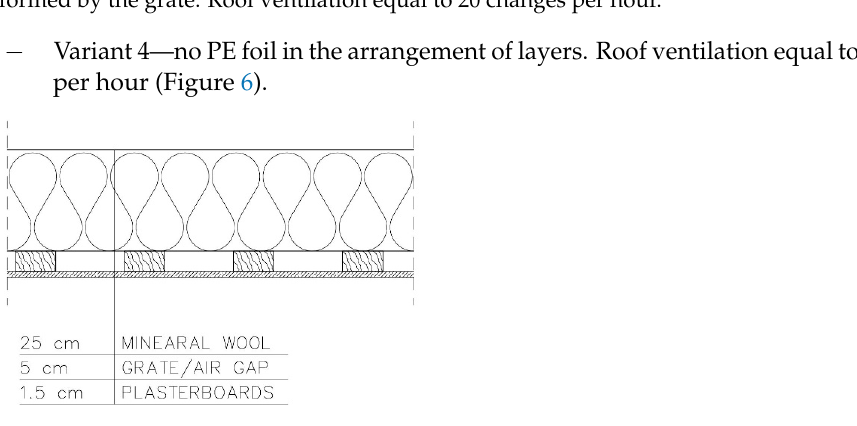
Figure 6. Variant 4: no PE foil in the arrangement of layers. Roof ventilation equal to 20 changes per hour. − Variant 5—no PE foil in the arrangement of layers. No roof ventilation (Figure 7).